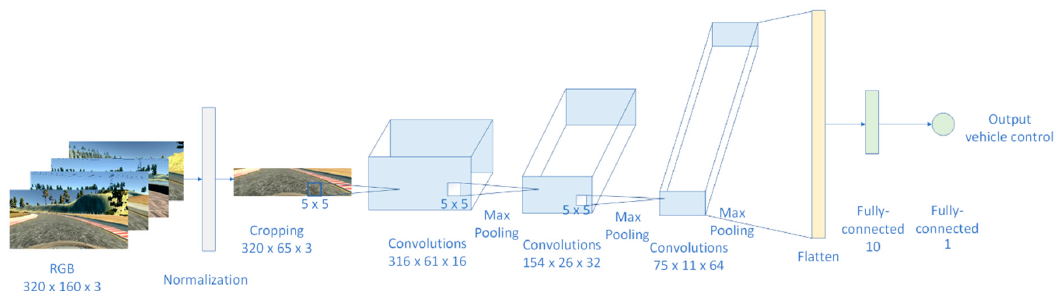
Figure 12. Architecture of proposed end-to-end deep neural network, J-Net, used for autonomous driving. The network has three convolutional layers with 16, 32, and 64 feature maps, one flattened layer, and two fully-connected (dense) layers. Max pooling is placed after every convolutional layer.